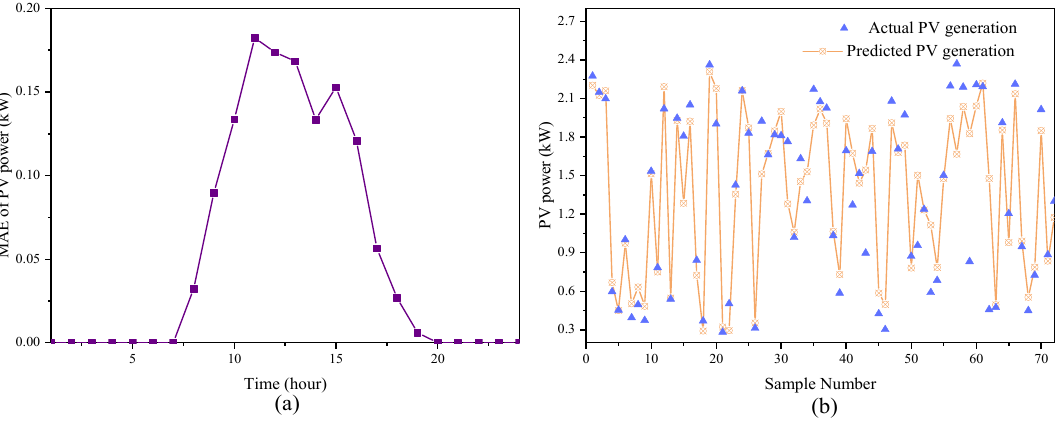
Figure 11. Actual and predicted PV power. ( a ) MAE of predicted PV power of a typical day; ( b ) predicted and actual PV power for time period of 11–12 o’clock.